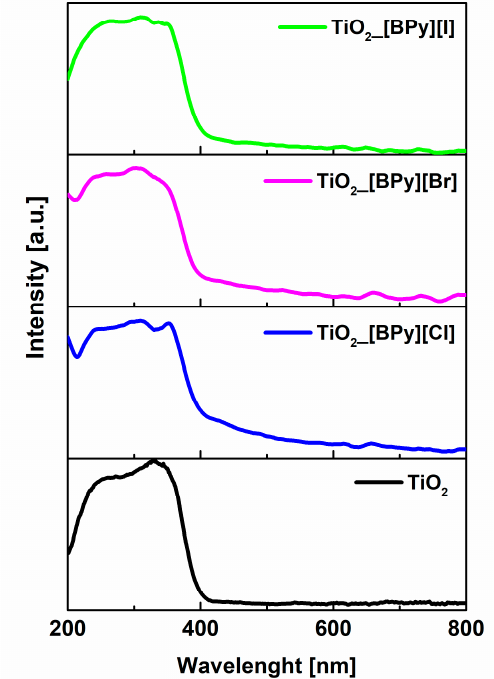
Figure 4. UV-Vis absorption spectra of pristine TiO 2 and TiO 2 obtained using ionic liquid containing various anions. Table 1. Elemental composition (in at. %) and chemical characters of titanium states in the surface